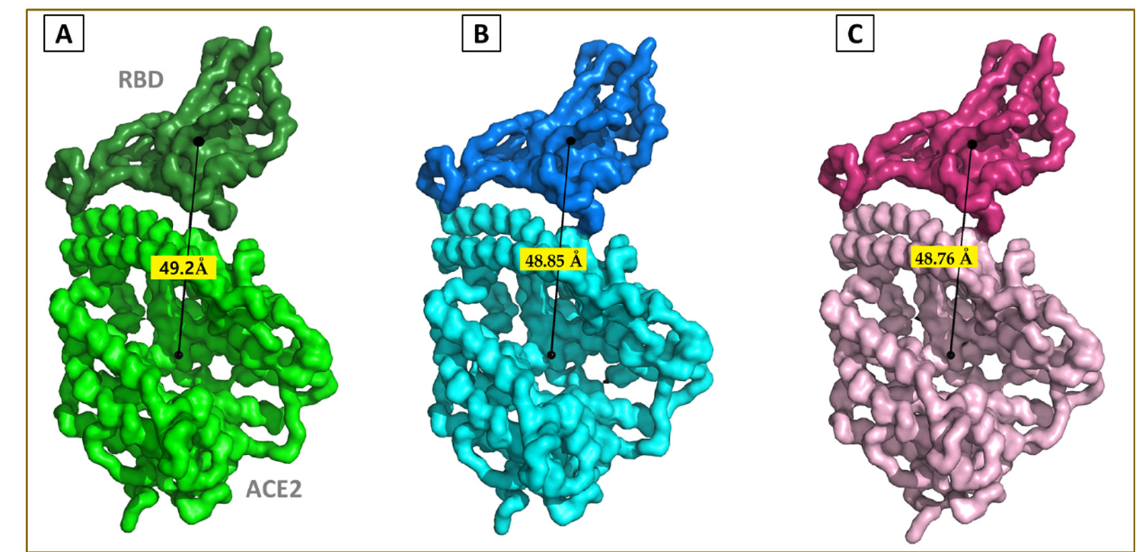
Figure 5. The average lateral drift between the COM of ( A ) wtRBD and ACE2, ( B ) kRBD and ACE2, ( C ) dRBD and ACE2.